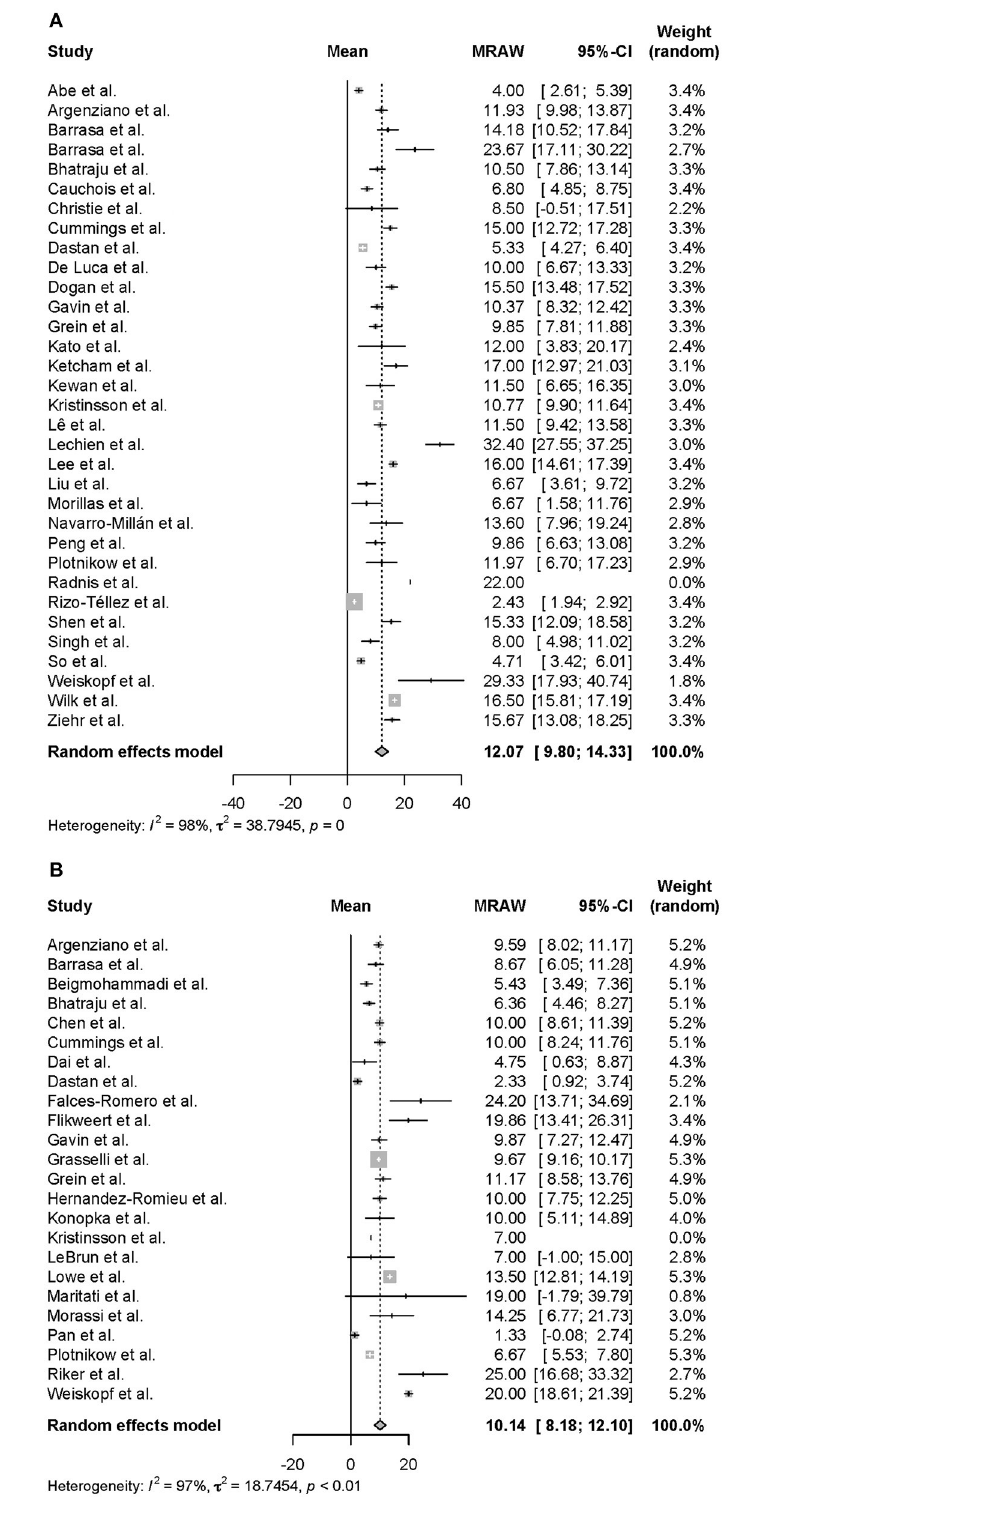
FIGURE 2 | Forrest plot: a meta-analysis of the intubation period and the intubation-death period. The intubation period of intubated COVID-19 survivors (A) and the intubation-death period of intubated COVID-19 non-survivors (B) were calculated using the random effects model. MRAW, the raw data of mean; 95% CI, 95% confidence